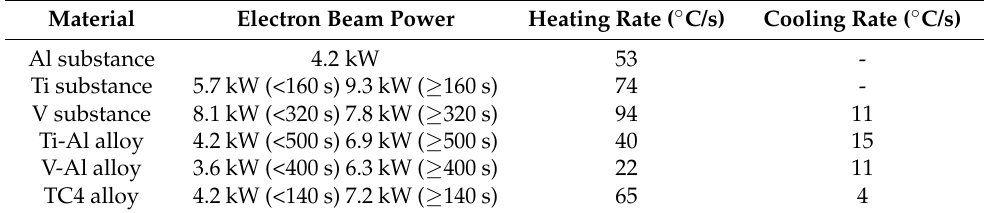
Table 3. Electron beam power and average heating and cooling rates in the experiment.